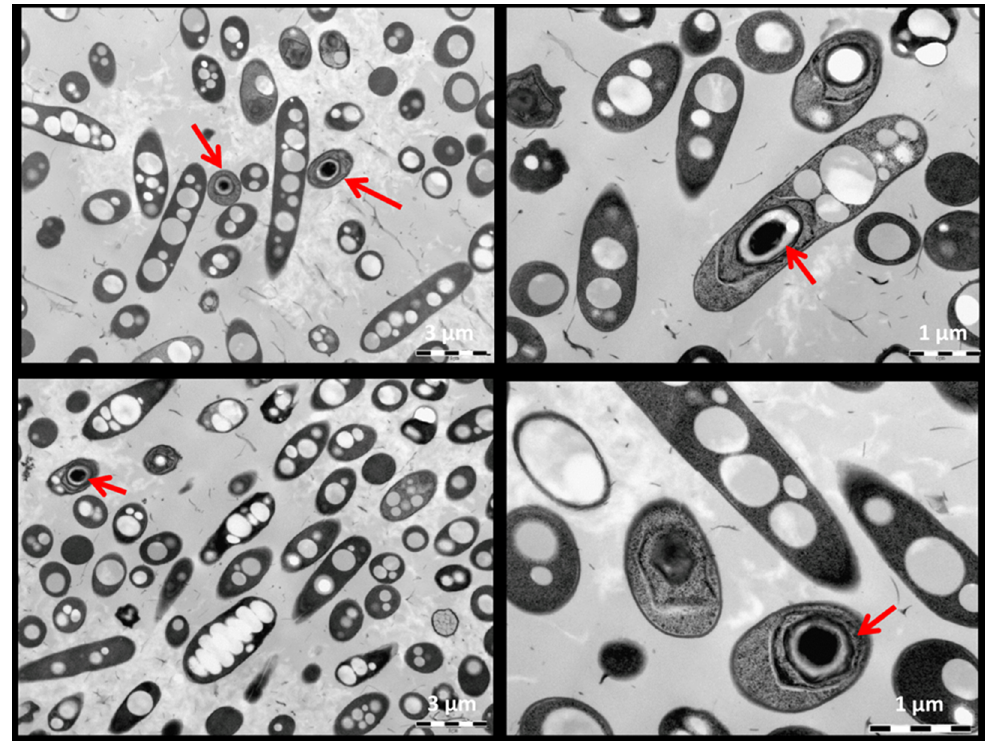
Figure 2. Morphology of the cells of Aneurinibacillus sp. H1 observed by TEM; the red arrows show endospores in bacterial cells.